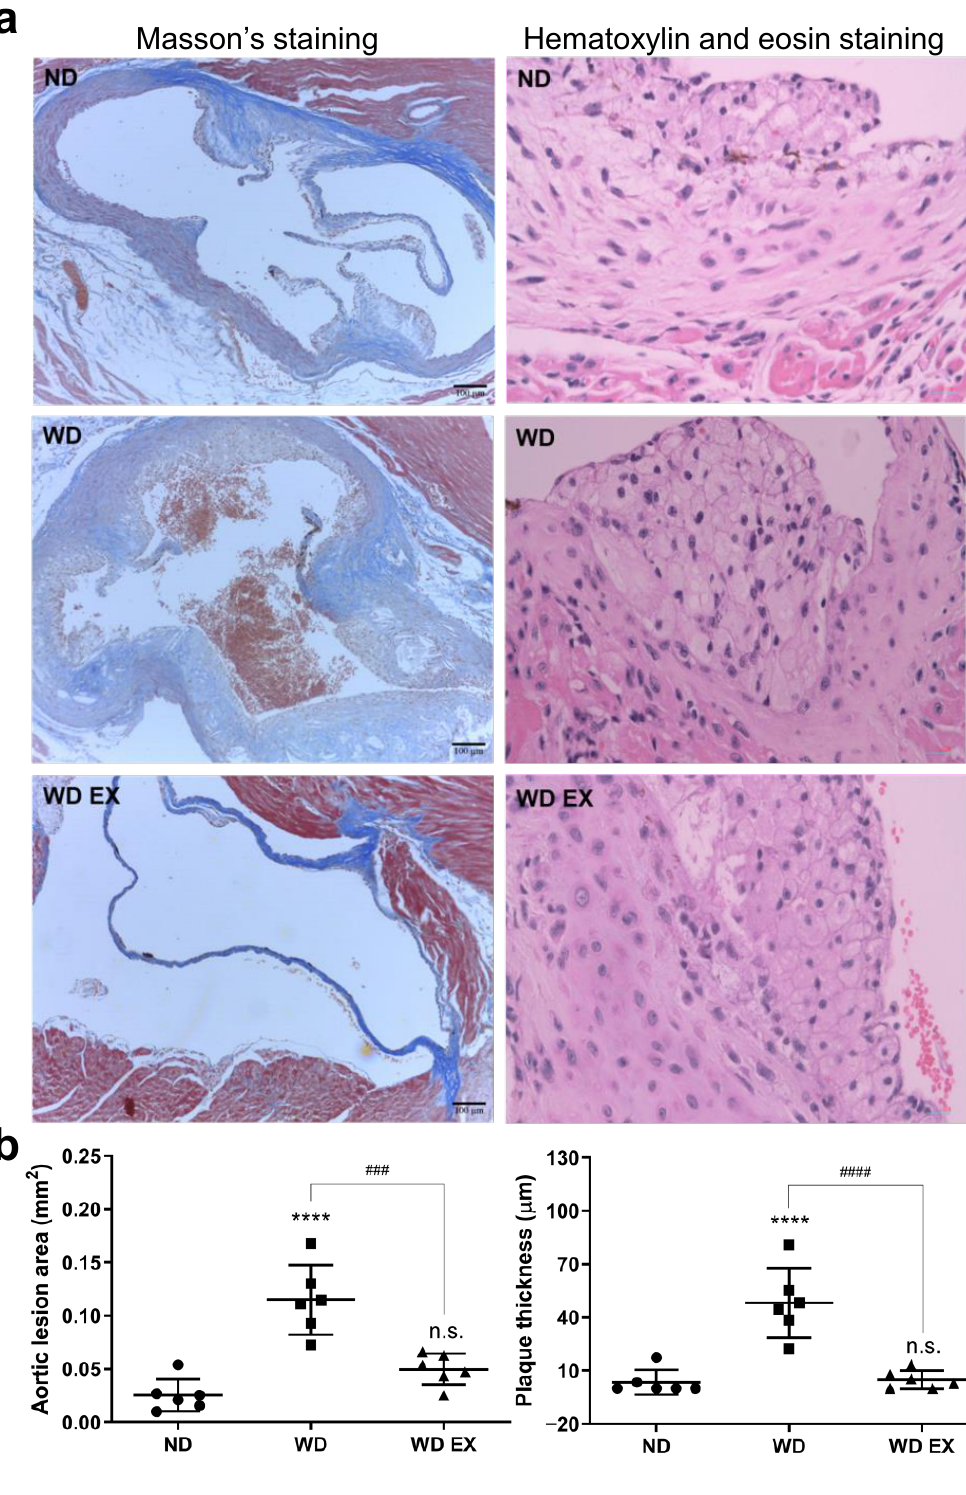
Figure 1. Effects of exercise on ( a ) Masson’s staining and hematoxylin and eosin staining, and ( b ) quantification of the aortic lesion area and plaque thickness in ApoE knockout mice. The results are expressed as means ± standard deviation ( n = 6). One-way ANOVA followed by Tukey’s post hoc test was used for statistical analysis, and **** p < 0.0001 represents the significance between ND and WD groups. ### p < 0.001 and #### p < 0.0001 represents the significance between WD and WD EX groups. n.s. = No significant difference.